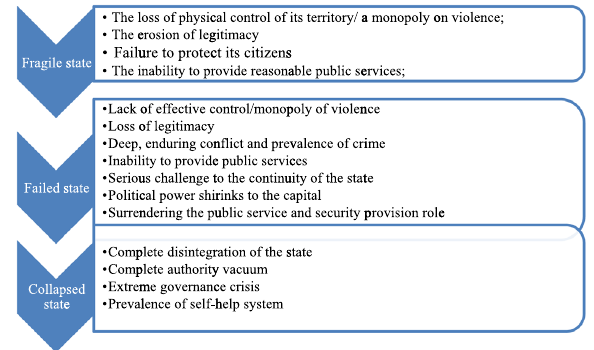
Fig. 1 Concepts with their corresponding indicators. Source: Author ’ s own